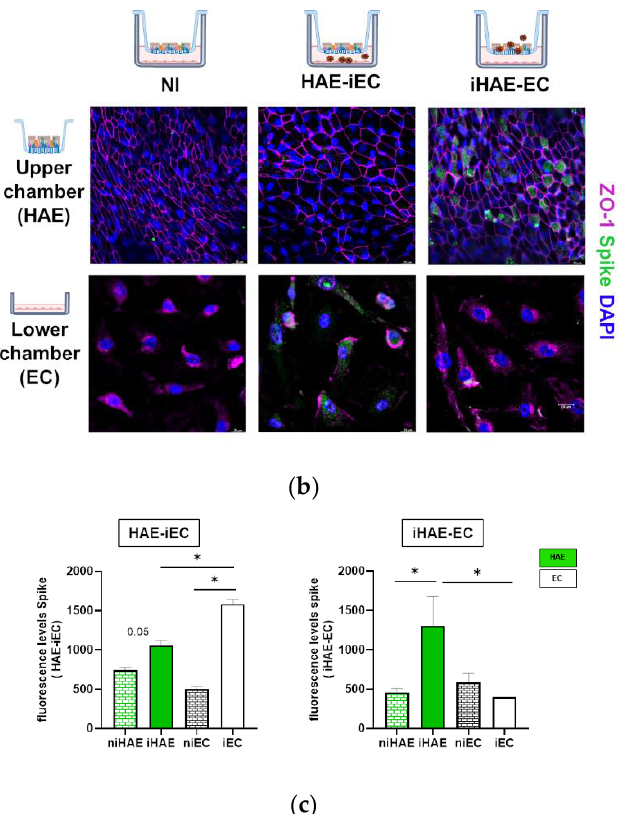
Figure 2. HAE-EC co-culture sustains SARS-CoV-2 replication. ( a ) SARS-CoV-2 RNA quantification in HAE (green bar) and ECs (white bar) at two days post-infection (n = 6 independent experiments) in iHAE, iEC cultured alone, or in co-culture HAE-iEC or iHAE-EC. Data are shown as mean + SEM. ( b ) Representative immunofluorescence analysis of upper and lower chamber after two days of co-culture with uninfected (NI) or SARS-CoV-2 infected EC (HAE-iEC) or HAE (iHAE-EC) (n = 6). Cells were stained for ZO-1 (purple) and Spike (green) antibodies. Thunder images were taken at a magnification of 63×. Nuclei were stained with DAPI (blue). Scale bars = 20 µm. ( c ) Fluorescence levels of Spike protein in HAE-EC co-culture in SARS-CoV-2 infected EC (HAE-iEC) or HAE (iHAE-EC). Values are presented as mean ± SEM. Mann-Whitney test was used for group comparison. * = p < 0.05.